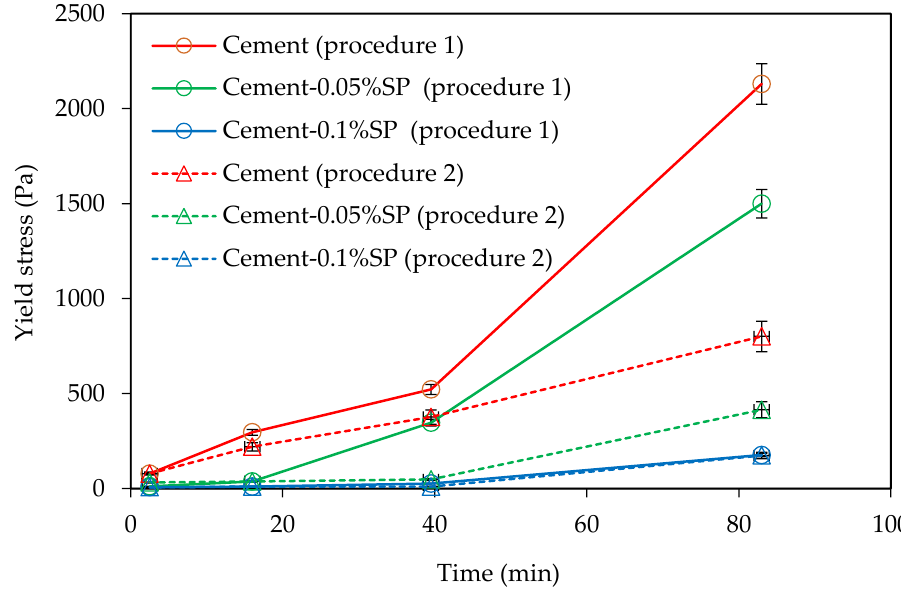
Figure 5. Effect of the superplasticizer dosage on the evolution of the static yield stress.